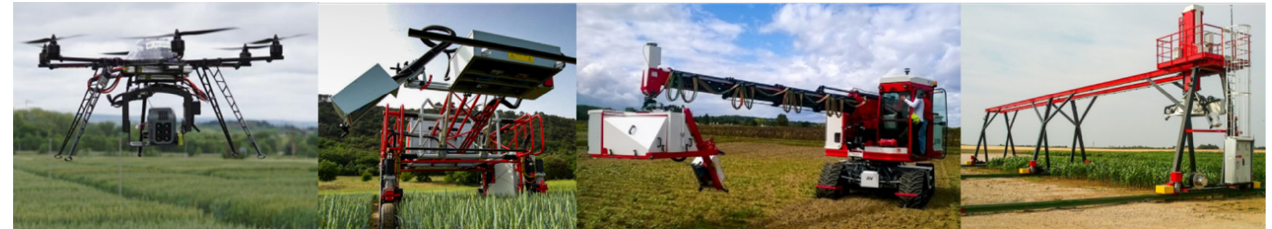
Figure 4. Different phenotyping systems used within the BREEDWHEAT project. From left to right: UAV equipped with a multispectral camera; Phenomobile V1 for crops lower than 1.2 m in height; Phenomobile V2 for crops up to 3 m in height; and the gantry system set up on PhenoField [95].